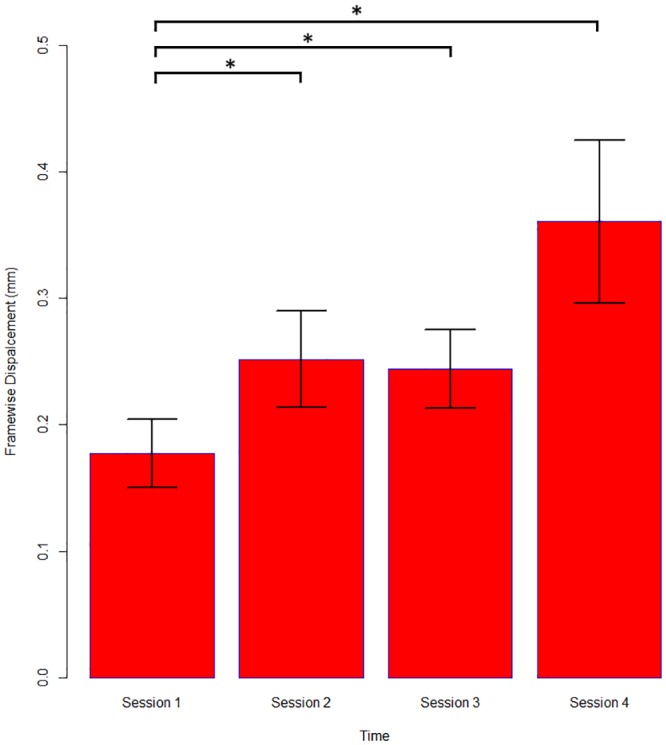
Movement as a function of time.There is an increase of movement of approximately 40% in the second and third session and of 100% in the fourth session relative to the first. The bars represent the mean in-scanner movement for each session across patients and controls irrespective of the effect of video and age. The standard error is represented by T bars. Amount of movement for sessions 2–3 and 4 were significantly greater compared to session 1 (p< 0.05). Significant differences marked with asterisk.